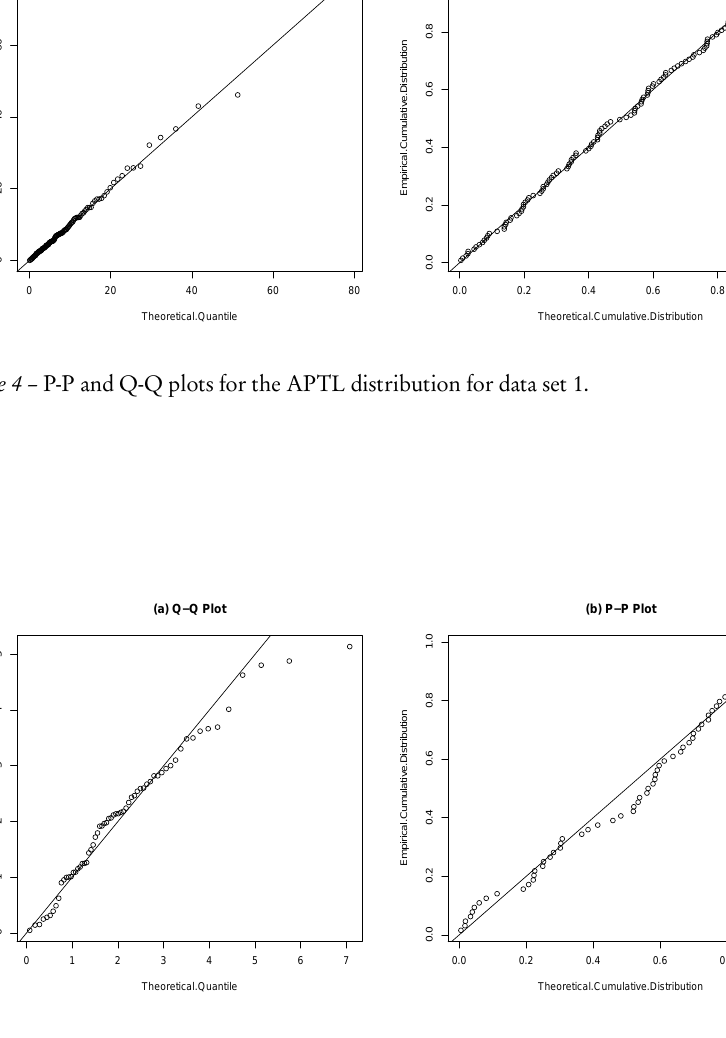
Figure 5 – P-P and Q-Q plots for the APTL distribution for data set